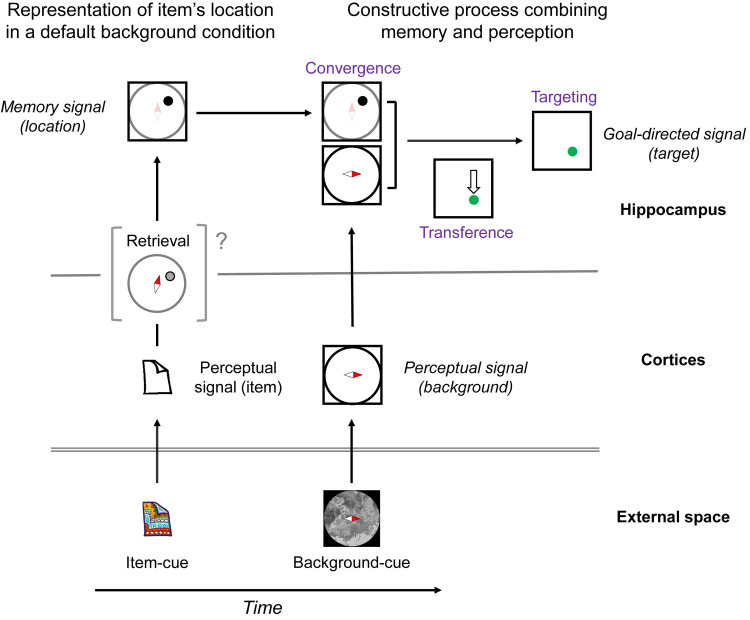
Constructive process for the flexible use of memory.Schematic diagram of neuronal signals during a trial of the CMP task, in which the item cue and the orientation of background cue were I-B and 90°, respectively. In the HPC, the retrieved location of the item is represented relative to the 0° background image, which may correspond to the top right in egocentric space. The incoming perceptual signal is integrated with the memory signal to construct an updated information signaling the target location by following sequential neuronal operations: convergence (i.e., memory [co-location I on the 0° background] + perception [90° background]), transference (i.e., from the top right [co-location I on the 0° background] into the bottom right [co-location I on the 90° background]), and targeting (i.e., coding bottom right). It is still unknown which brain area is involved first in the retrieval of item-location association memory and whether the retrieved memory content is same as the memory signal in the HPC. CMP, constructive memory-perception; HPC, hippocampus.